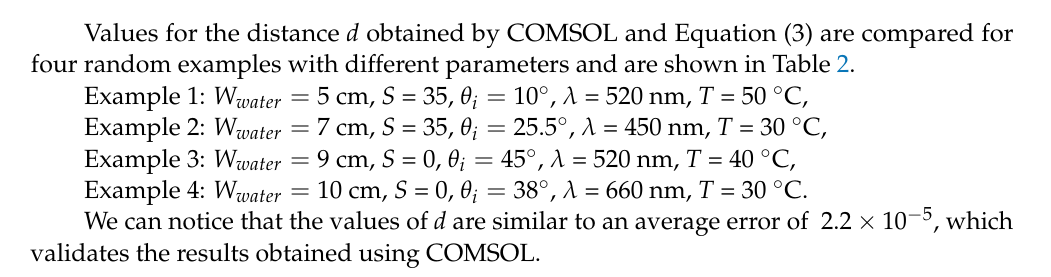
four random examples with different parameters and are shown in Table 2.